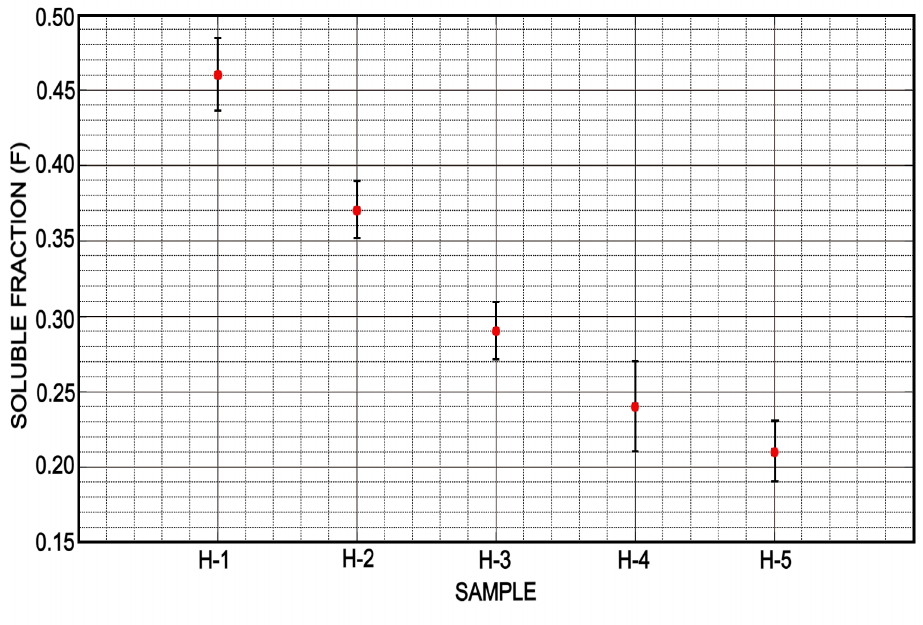
Figure 15. Samples H-3, H-4 and H-5 showed a very similar soluble fraction; however, samples H-1 and H-2 showed a higher value indicating a higher degree of polymer loss caused by the swelling and drying processes, which is counterproductive in desirable